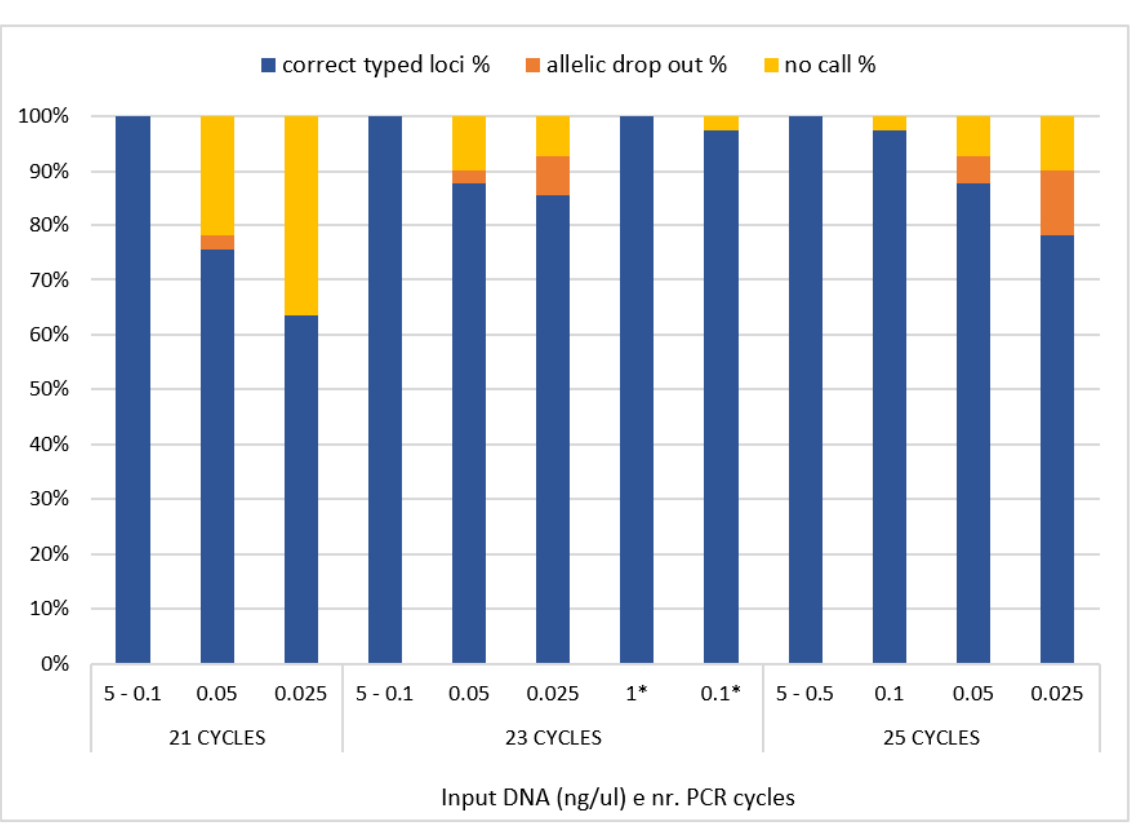
Figure 4. The figure shows the assessment of 41-SNPs panel sensitivity on control DNA samples. Reliable profiles were observed with 100 pg DNA input or higher. An increase in allelic drop-out events and decrease in no-call were observed with lower amount of DNA. * Libraries prepared with half reaction volume.